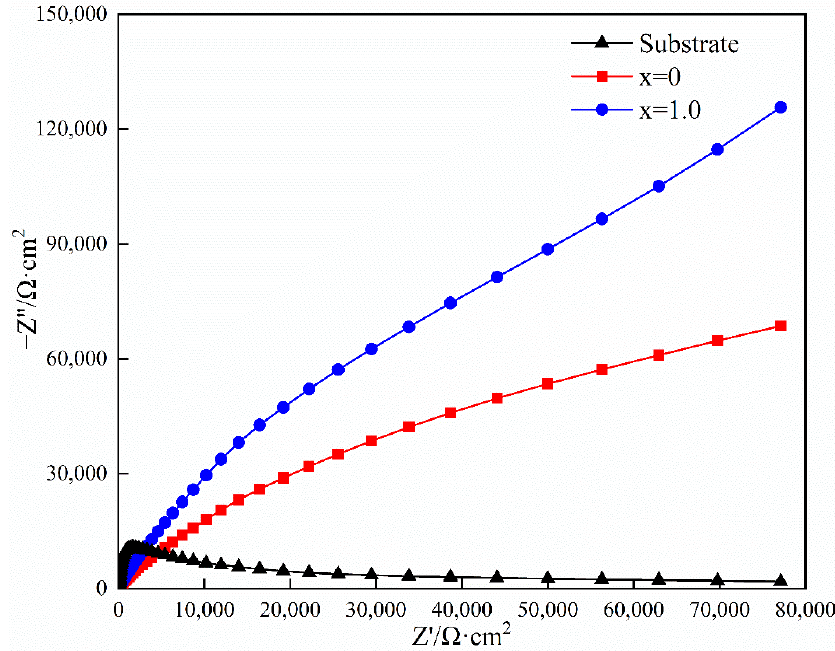
Figure 7. Nyquist plots recorded on the samples in the 3.5 wt.% NaCl solution.